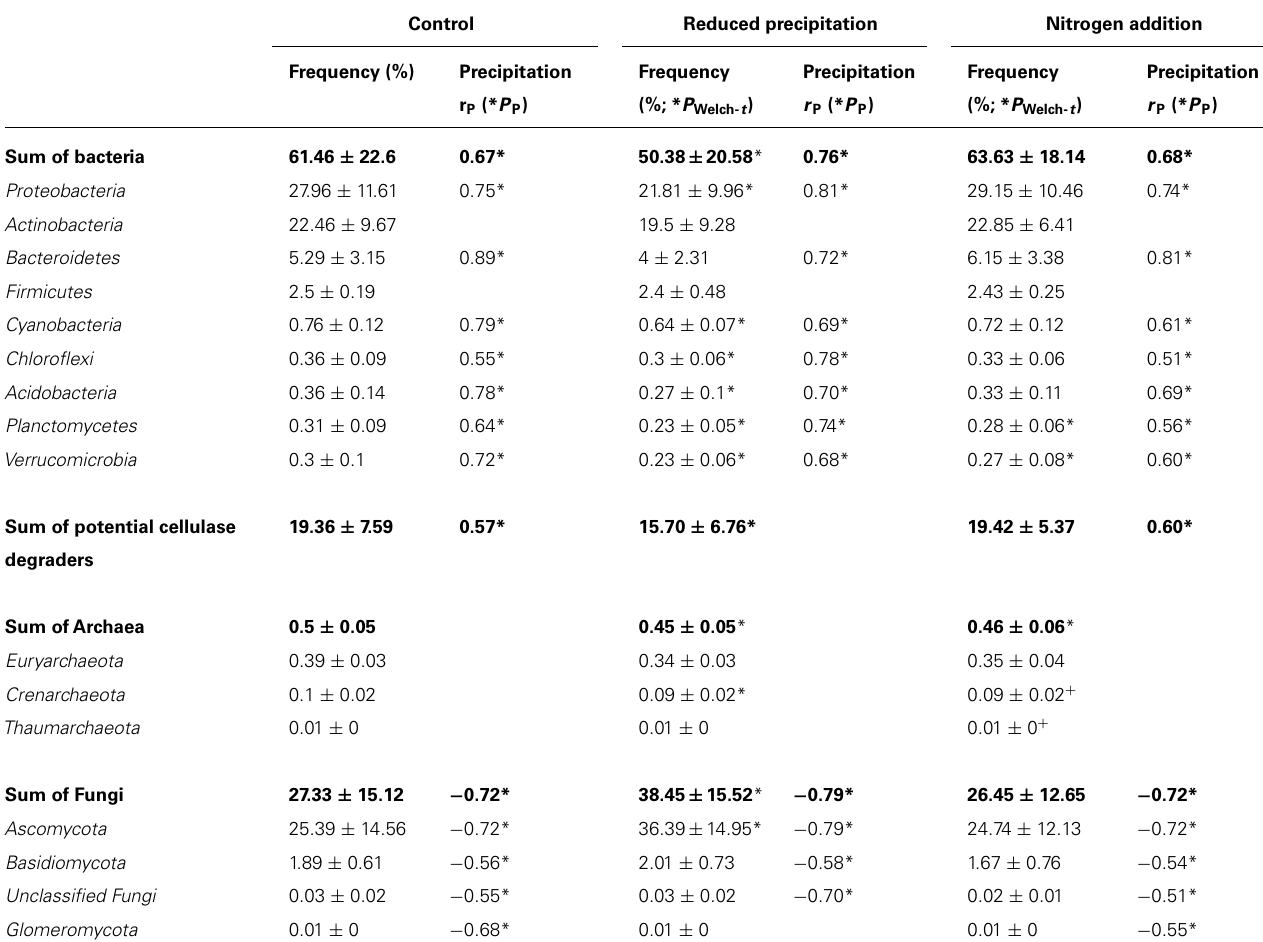
Table 1 |Average frequency (%) of rarefied reads for the most abundant microbial lineages detected in leaf litter